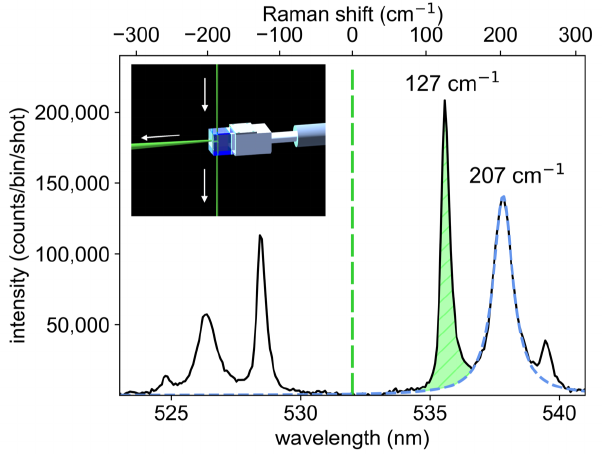
Figure 3. Raman scattering spectrum from the quartz crystal probe. The much brighter Rayleigh signal at 532 nm is effectively blocked by the notch. The area under the 127 cm − 1 Stokes–Raman line (shaded green) is used to absolutely calibrate the spectrometer. It overlaps with the broad Lorentzian wings of the adjacent 207 cm − 1 line (dashed blue), which must be subtracted from the signal. The inset illustrates the beam intersecting the quartz probe from the top to bottom and the scattered light collected by the central